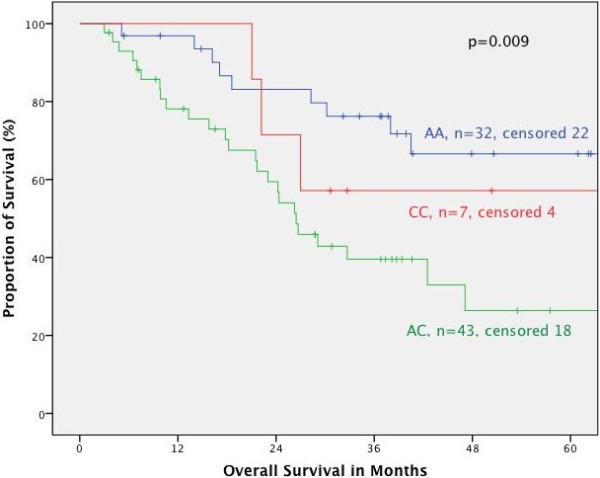
Survival in gastric cancer patients according to UICC 7th edition, MTHFR A1298C. Legend: Subgroup analysis for patients with adenocarcinoma of the stomach dependent on polymorphisms of MTHFR A1298C. Median Survival times: AA 82.7 months, CC not reached, AC 26.5 months, p = 0.009.